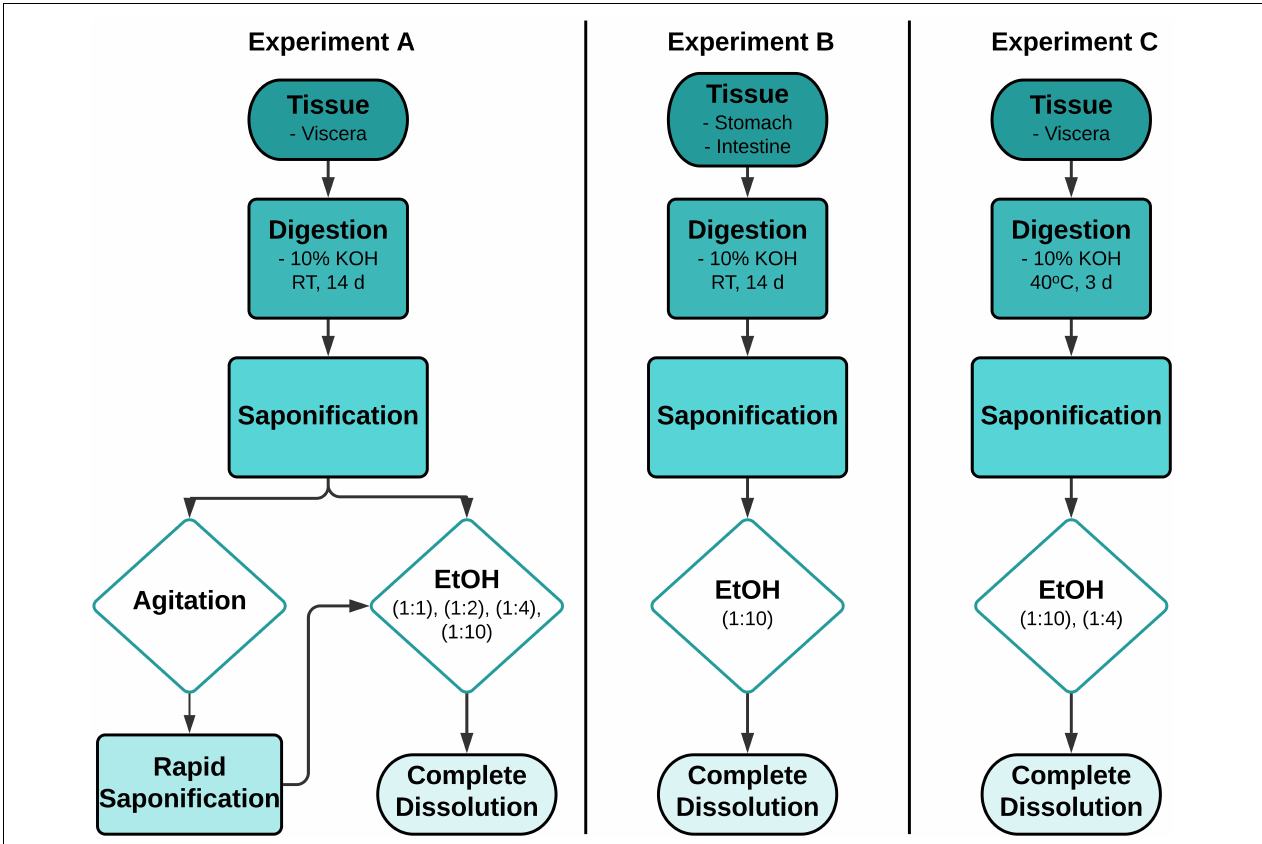
FIGURE 1 | Workflows outlining the process of optimizing the treatment of 10% potassium hydroxide (KOH) digested lipid-rich fish tissues. RT -room temperature, EtOH - ethanol, d- day, solvent ratios - 100% EtOH: Biota/KOH solution, v / v .